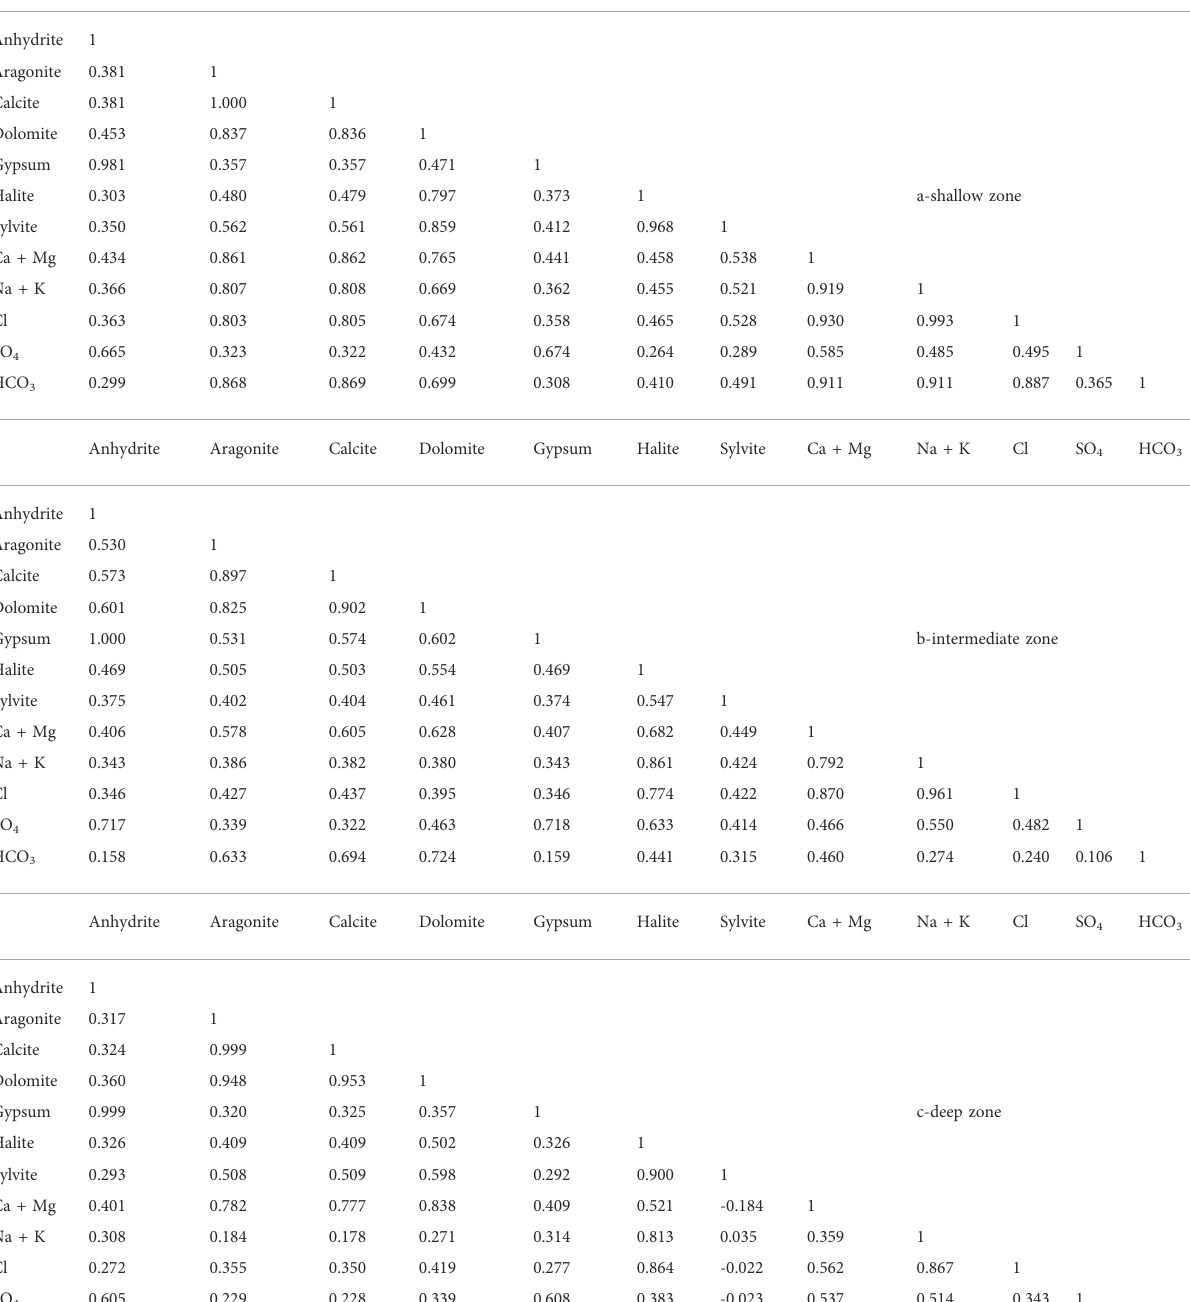
TABLE 3 Correlation coef fi cient matrix between SIs of the dissolved minerals and concentrations of the major ions. Anhydrite Aragonite